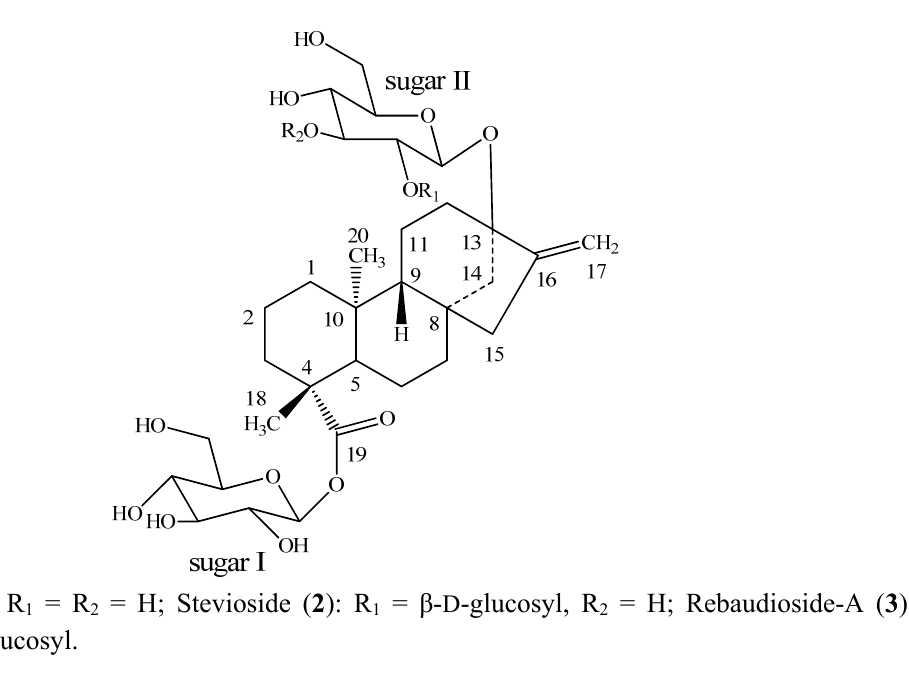
Figure 1. Structures of rubusoside ( 1 ), stevioside ( 2 ) and rebaudioside-A ( 3